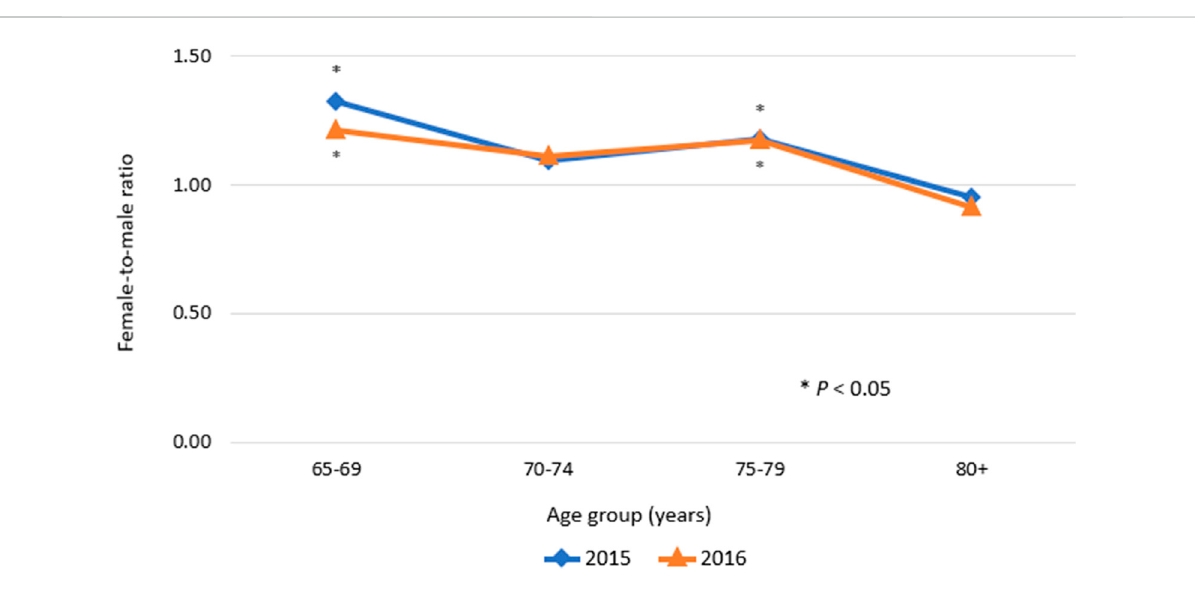
FIGURE 1 Female-to-male ratio of prevalence of adverse drug